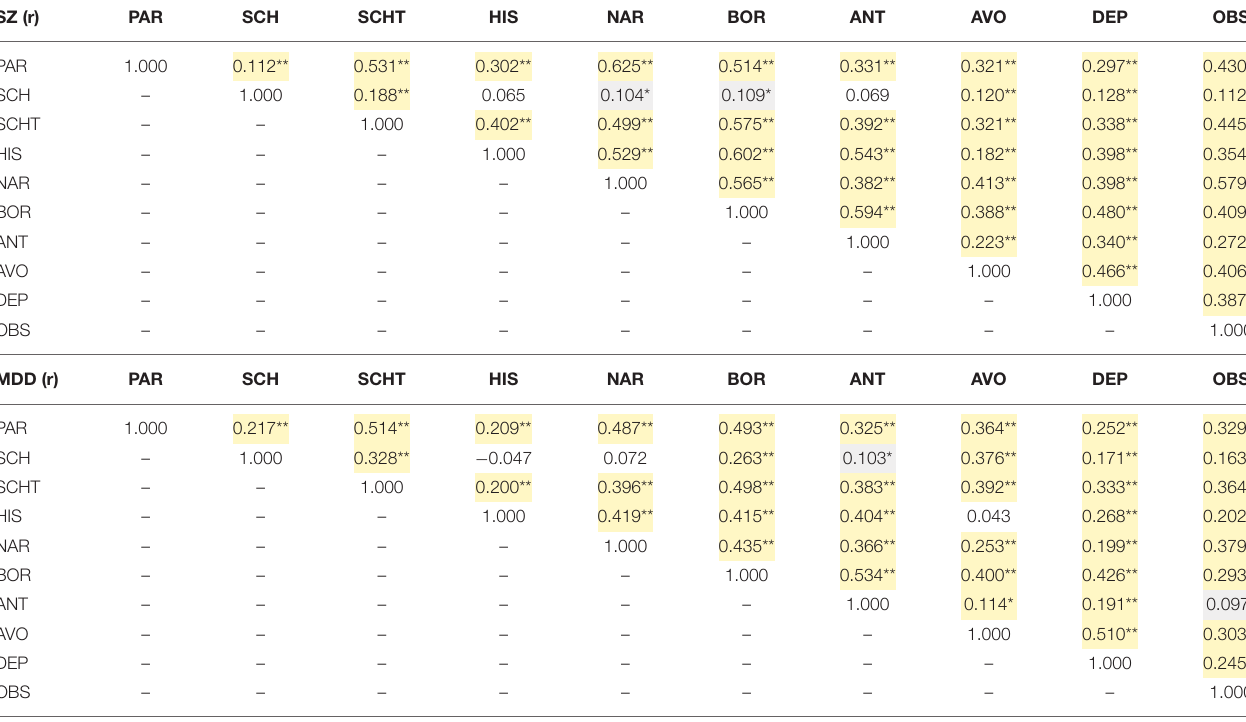
TABLE 2 | Correlations of different types of personality disorder traits in patients with schizophrenia and those with major depressive disorder. SZ (r)